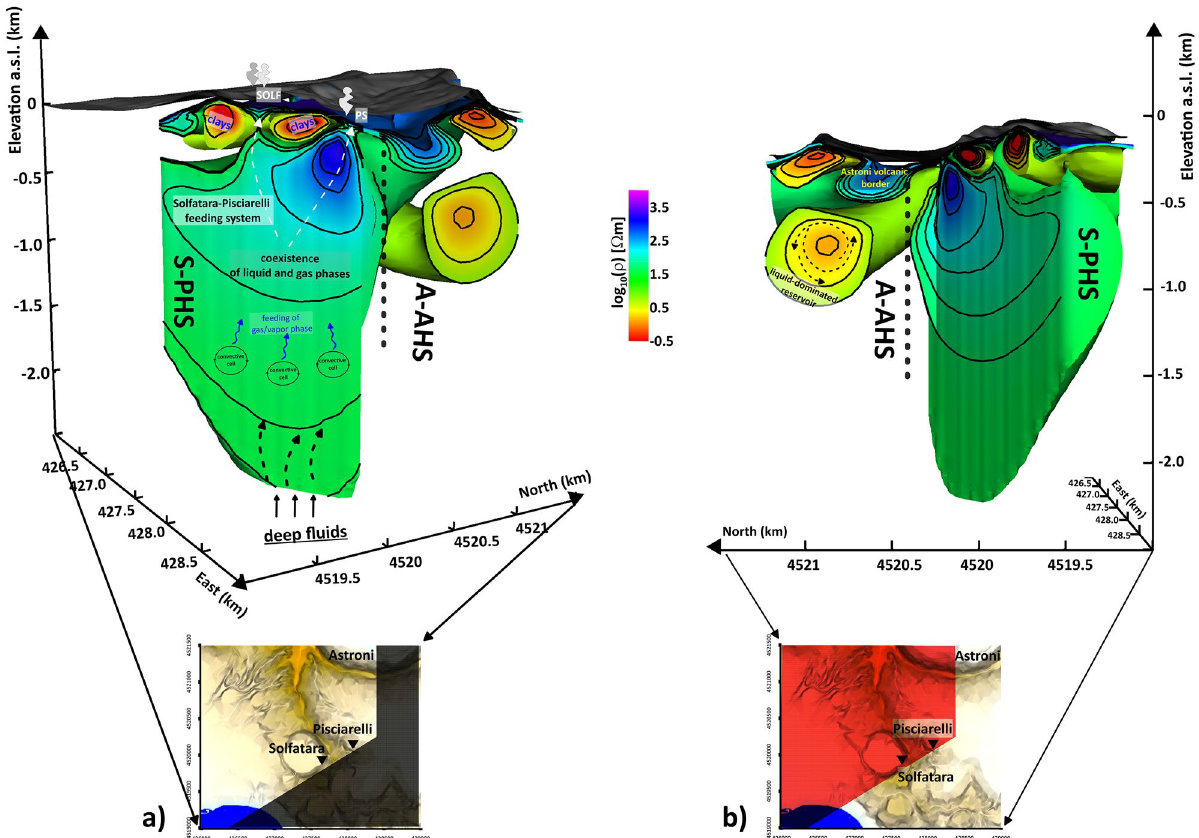
(PS) and the Solfatara (BG and BN) fumaroles is indicated. The common logarithmic scale represents the electrical